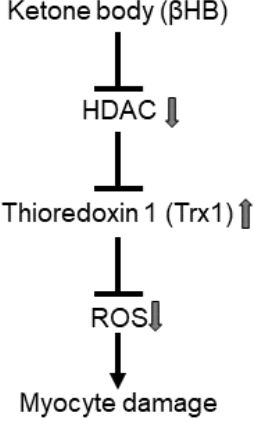
Figure 6. Schematic representation of ketone body-induced antioxidant defense. Ketone body up- regulates Trx1, possibly through HDAC inhibition, thereby potentiating the antioxidant